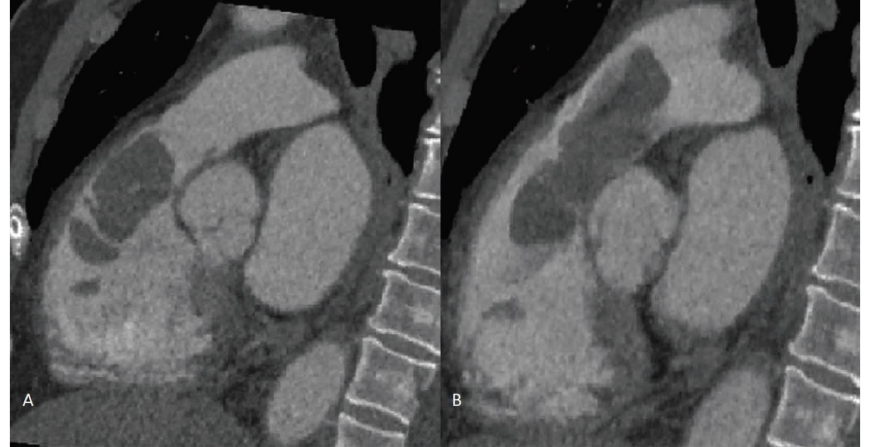
Figure 2: Gated computed tomographic angiography of the chest showing the mass in the RV (a) traversing the pulmonic valve into the main pulmonary artery. (b) Abbreviations: RV: right